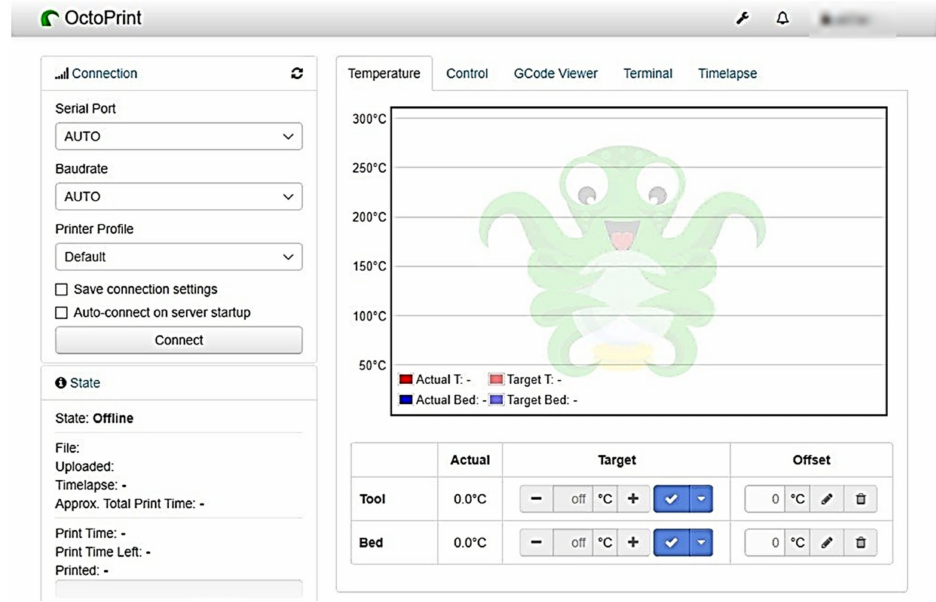
Figure 7. Setting up